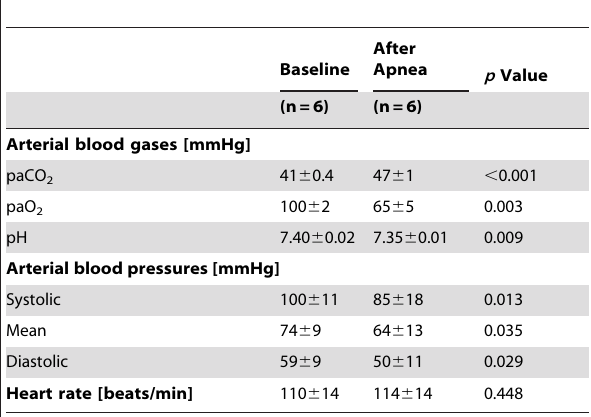
Table 1. Blood gas, blood pressure and heart rate analysis.